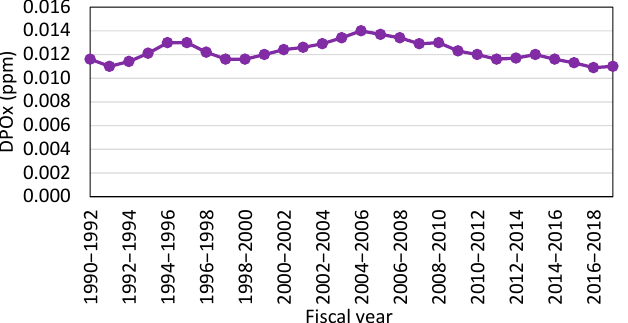
Figure 30. Trend in three-year moving averages of DPOx from April to October. Note: If the daytime Ox concentrations are lower than the previous day’s nighttime Ox concentrations, the day’s DPOx is zero, and the day’s DPOx is included in the averaged DPOx. Note: If the total number of hours with no measurement data is over 5 between the one day’s 9 p.m. and the next day’s 8 p.m., the day’s DPOx is excluded from averaged DPOx.